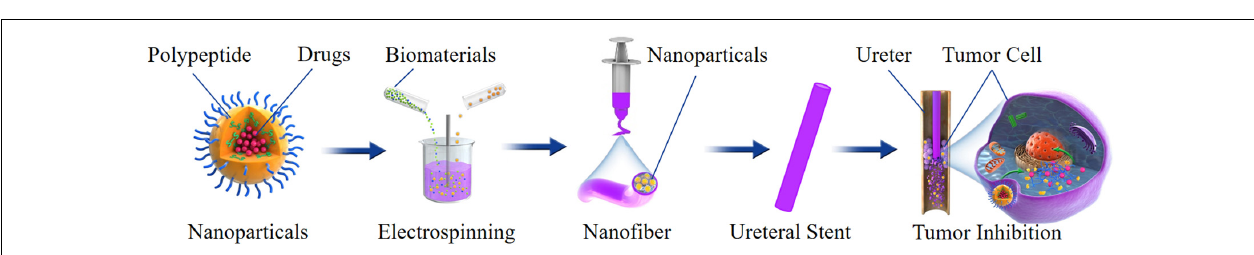
FIGURE 4 | Schematic illustration of preparation, structure and antitumor effect of a nanoparticles-based drug-eluting BUS.